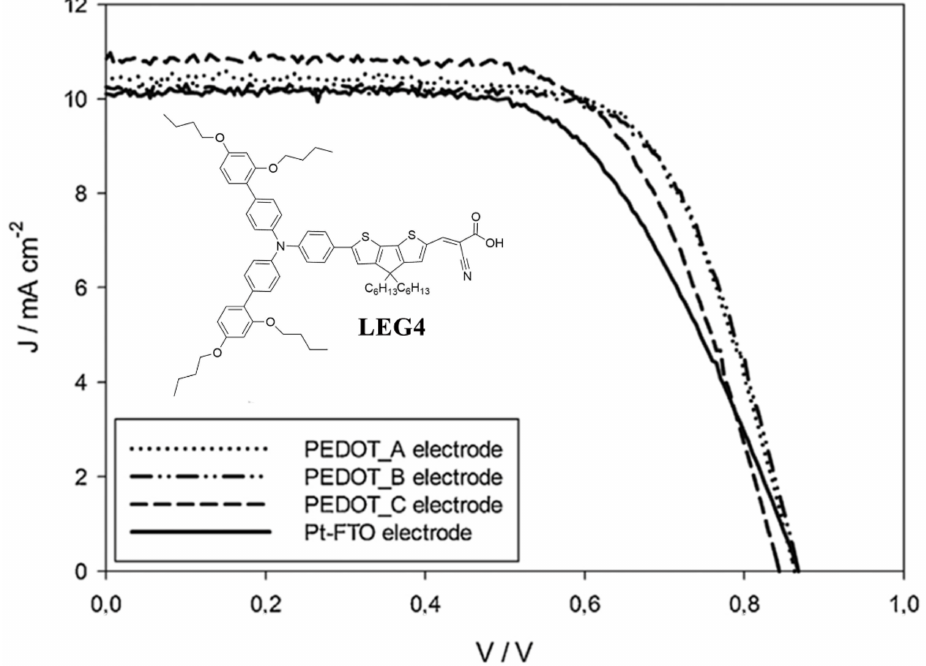
Figure 7. JV curves of cobalt mediated DSSCs sensitized by the organic dye LEG4, assembled with different PEDOT counter electrodes (PEDOT:SDS) where the thickness of the polymer films was varied. Adapted from Ref. [65], Copyright (2013), with permission from